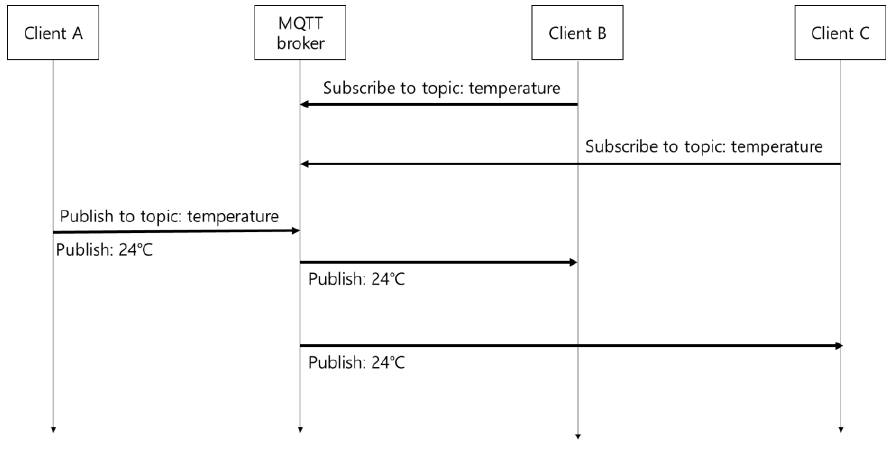
Figure 5. MQTT communication pattern.